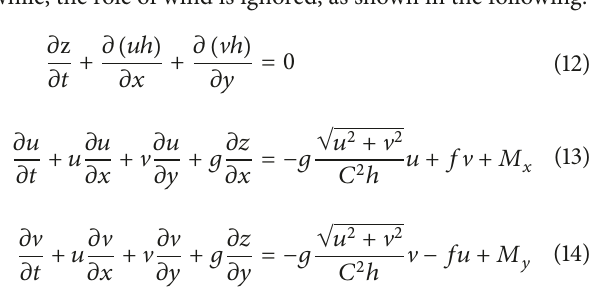
Figure 6: Flow passage